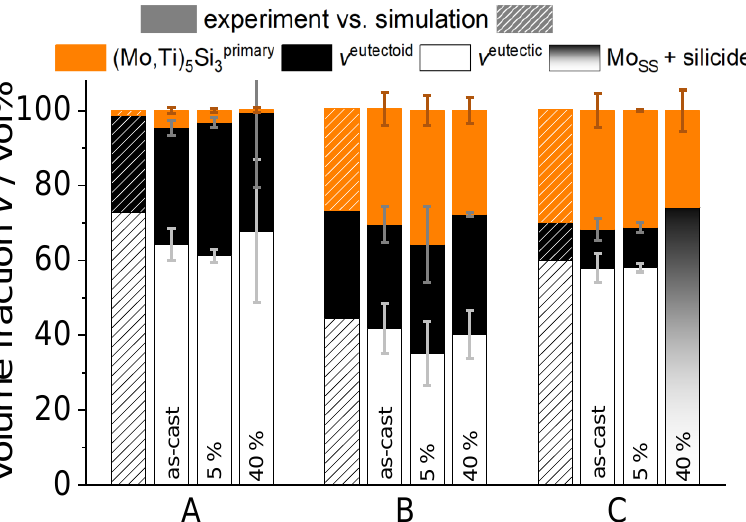
Figure A2. Thermodynamic predicted volume fractions (hatched bars) in comparison to the exper- imentally determined volume fractions of the microstructural constituents (filled bars) in as-cast condition and after compressive creep strain of 5 and 40% attained at 1200 °C, 200 MPa for the alloys A to C.